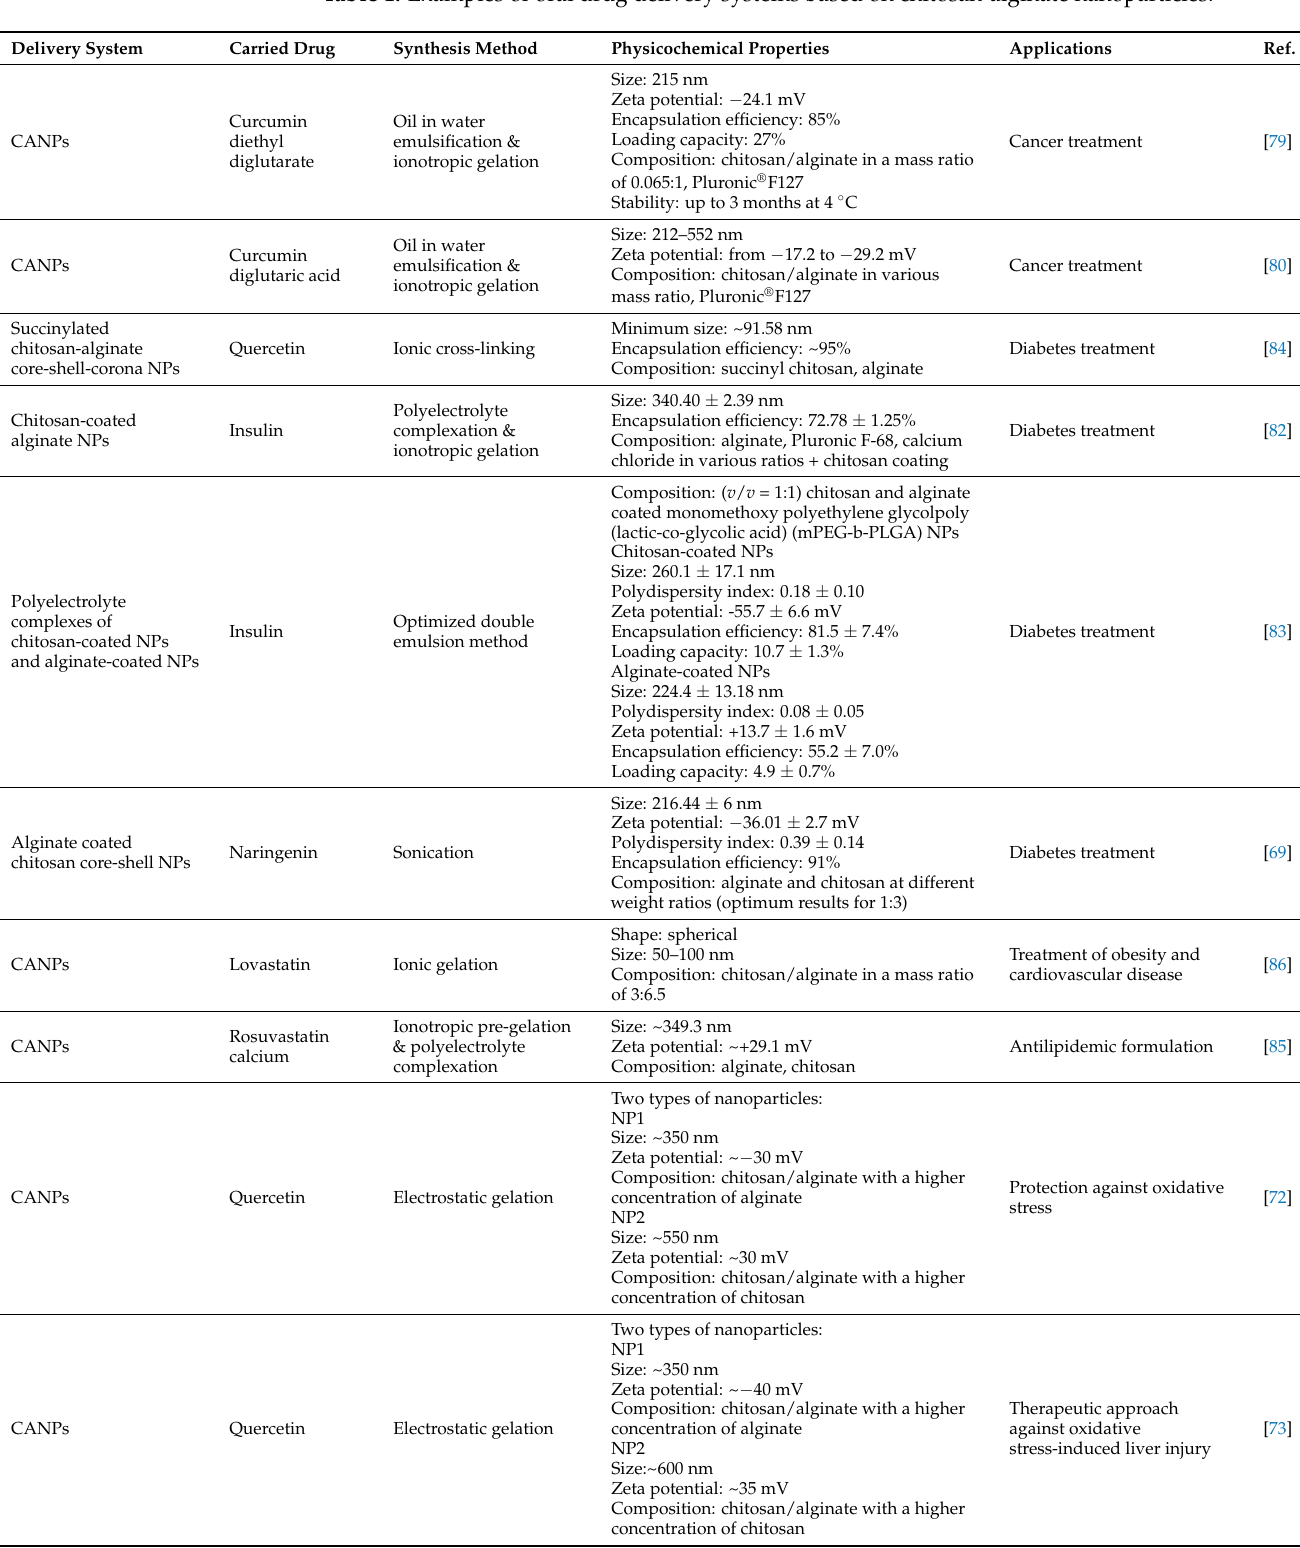
Table 1. Examples of oral drug delivery systems based on chitosan-alginate